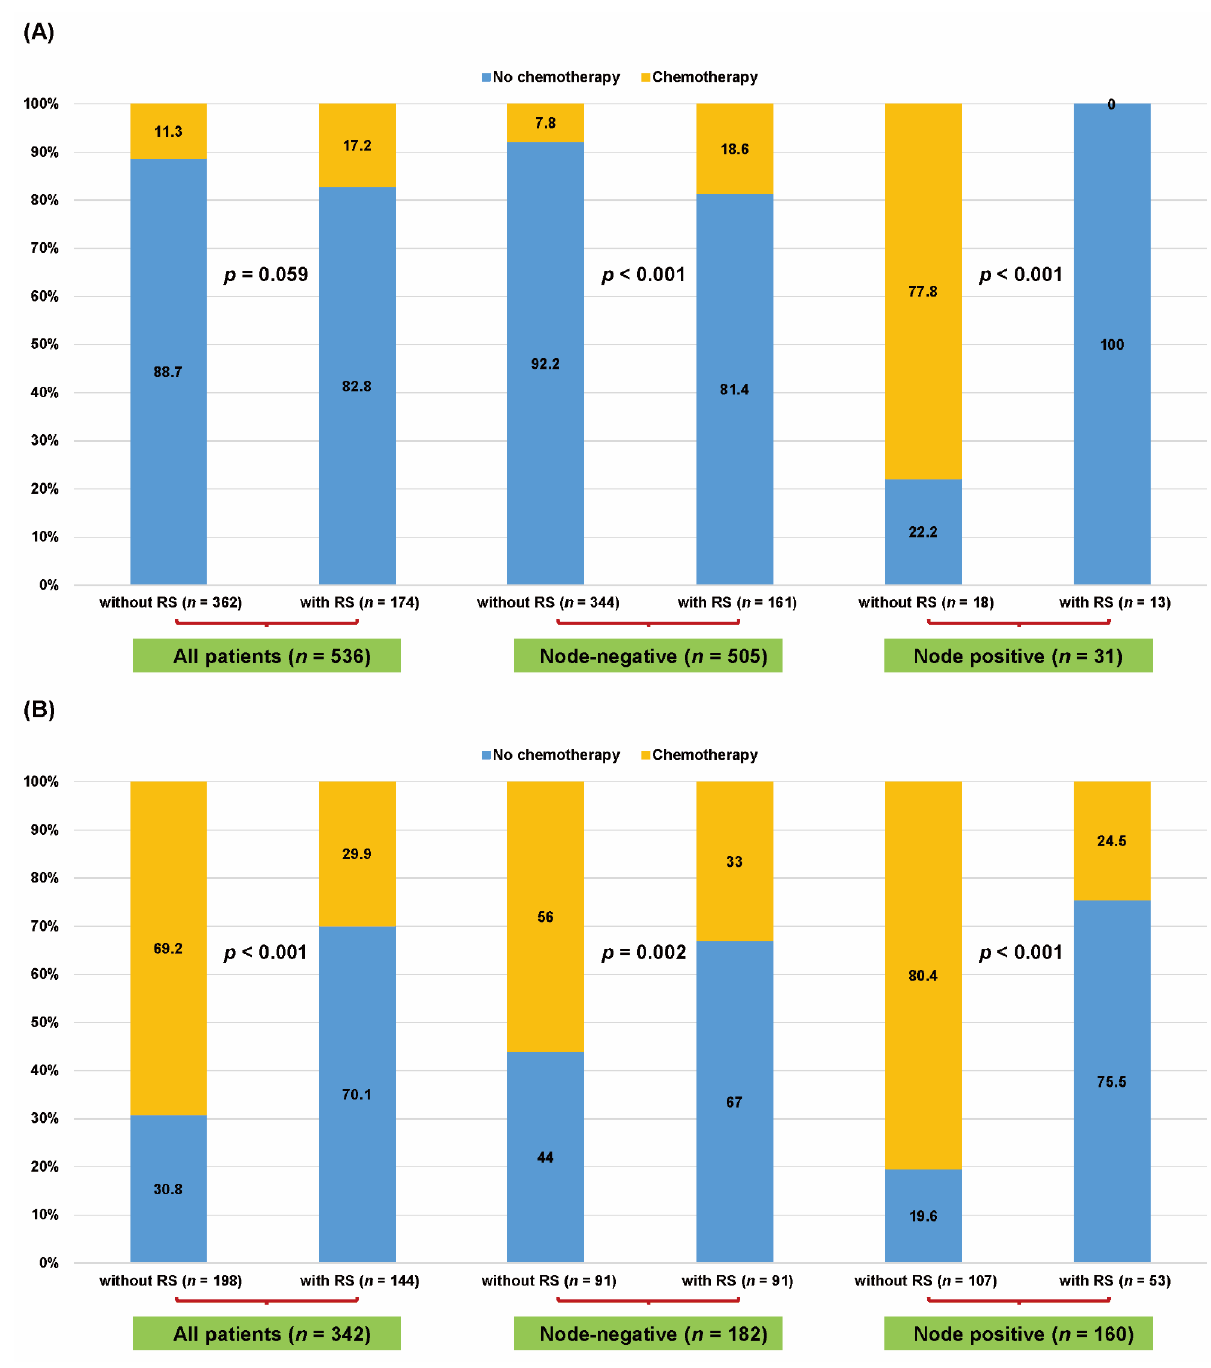
Figure 2. Chemotherapy rates according to the application of the 21-gene Recurrence Score (RS) assay in the entire cohort. Chemotherapy rates according to the application of the 21-gene RS assay stratified by clinical risk in patients with ( A ) low clinical risk and ( B ) high clinical risk. Chi-square test, significance level of